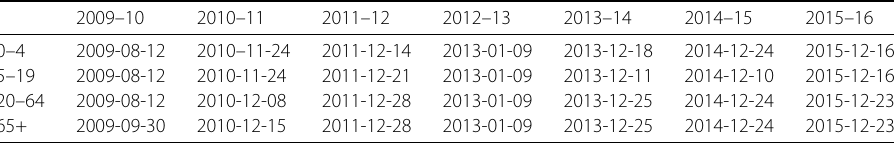
Table 2 The influenza start weeks for each age-group. Here, we record Wednesday of that week. Except for the 2011–12 season, the 5–19 age-group starts earlier than the other age-group